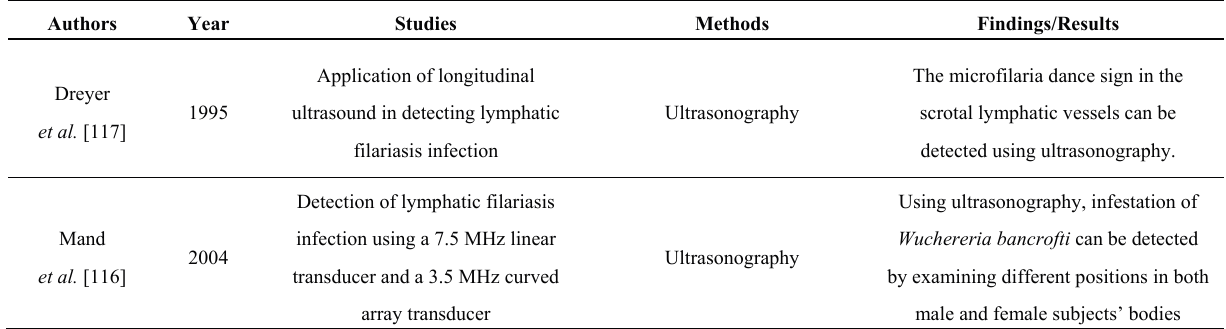
Table 8. Summary of biomedical engineering techniques in lymphatic filariasis